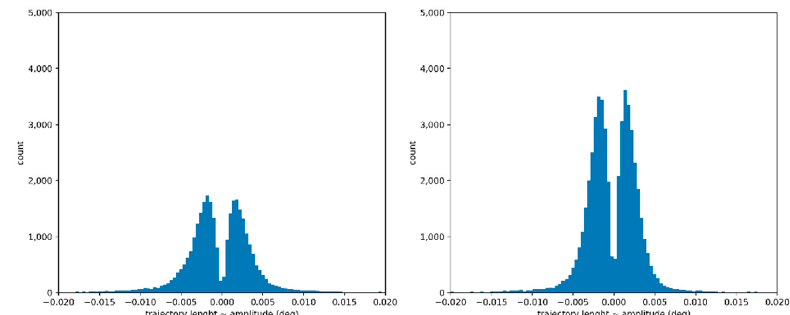
Figure A14. Histogram of the amplitude segments for the painting 3 dataset.